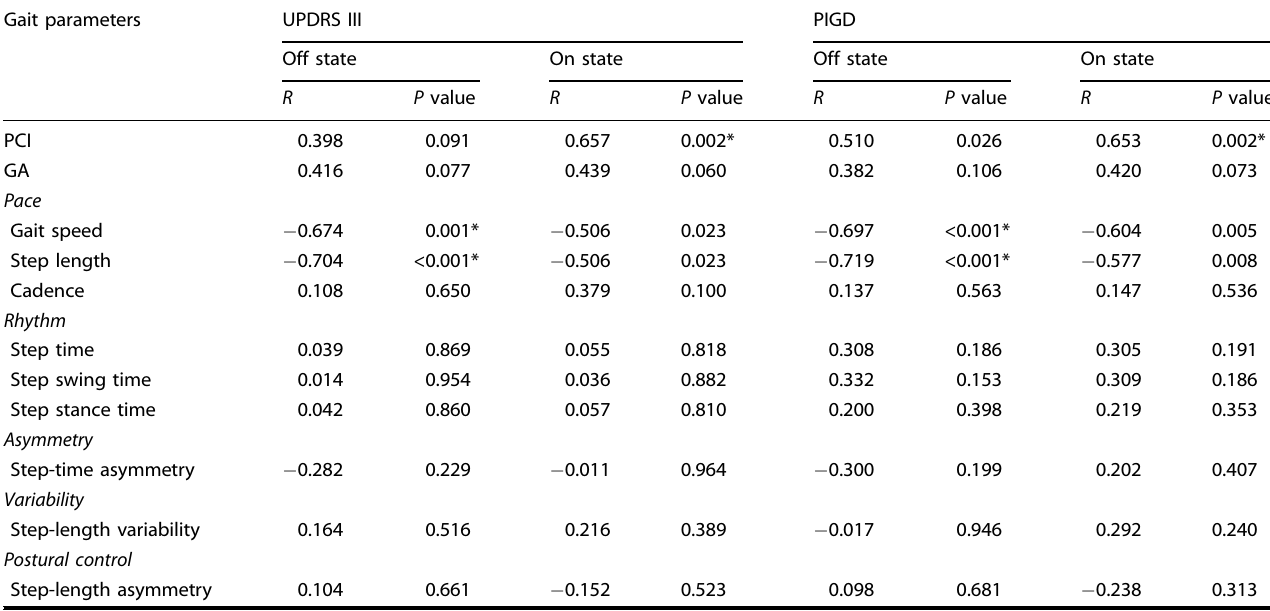
Table 3. Results of partial correlation analysis between UPDRS III, PIGD, and gait parameters.